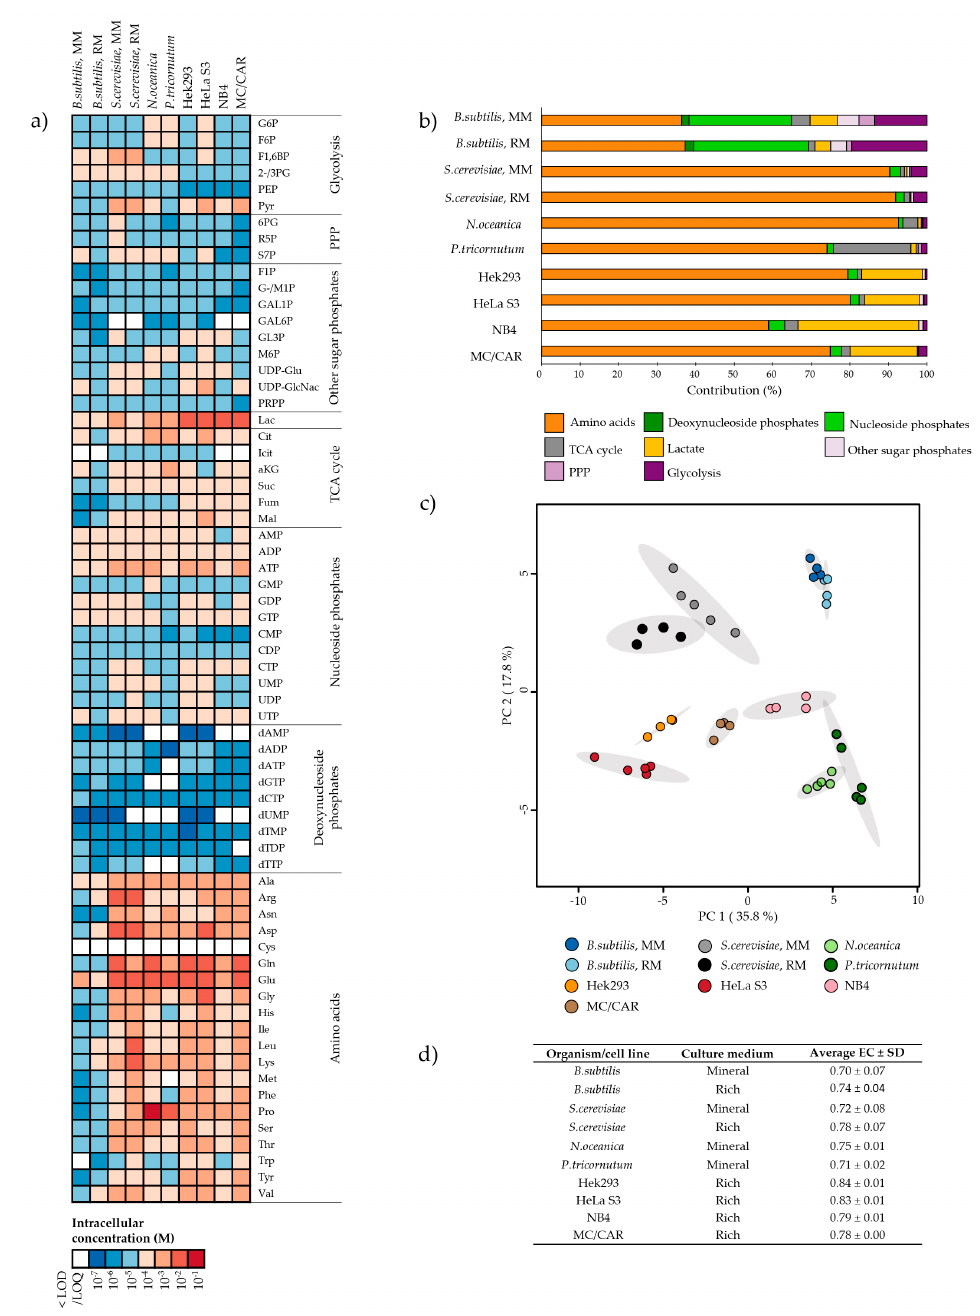
Figure 2. Intracellular metabolite levels in Bacillus subtilis, Saccharomyces cerevisiae, Nannochloropsis oceanica, Phaeodactylum tricornutum, and Hek293, HeLa S3, NB4, and MC / CAR cell lines. ( a ) Heat map of the average order of magnitude of intracellular concentrations (M), ( b ) contribution (%) of metabolite classes to the total measured level of metabolites, ( c ) scores plot from principal component analysis (PCA) of metabolite levels in all biological replicates with 95% confidence intervals [49], and ( d ) average energy charge (EC) ± standard deviation (SD). Rich media, RM; Mineral media, MM; TCA, tricarboxylic acid; PPP, pentose phosphate pathway. Metabolite abbreviations are listed in Table S1.